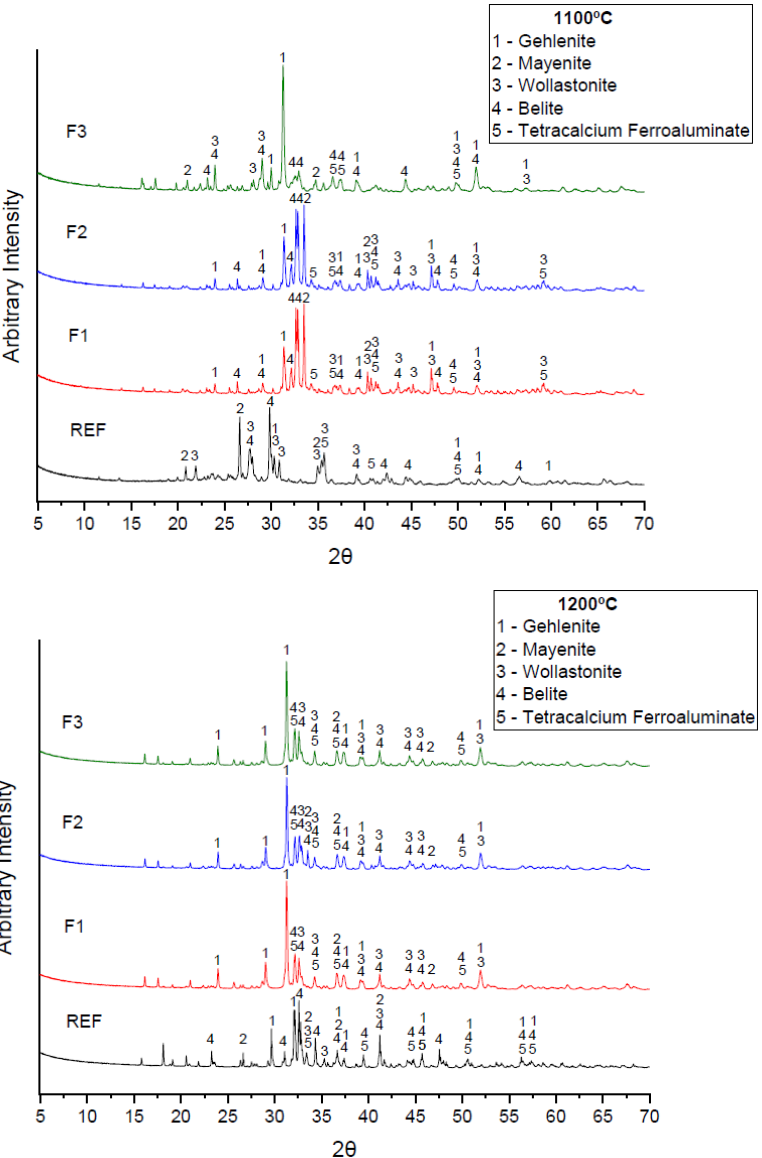
Figure 5. Mineral analysis of experimental clinkers produced.